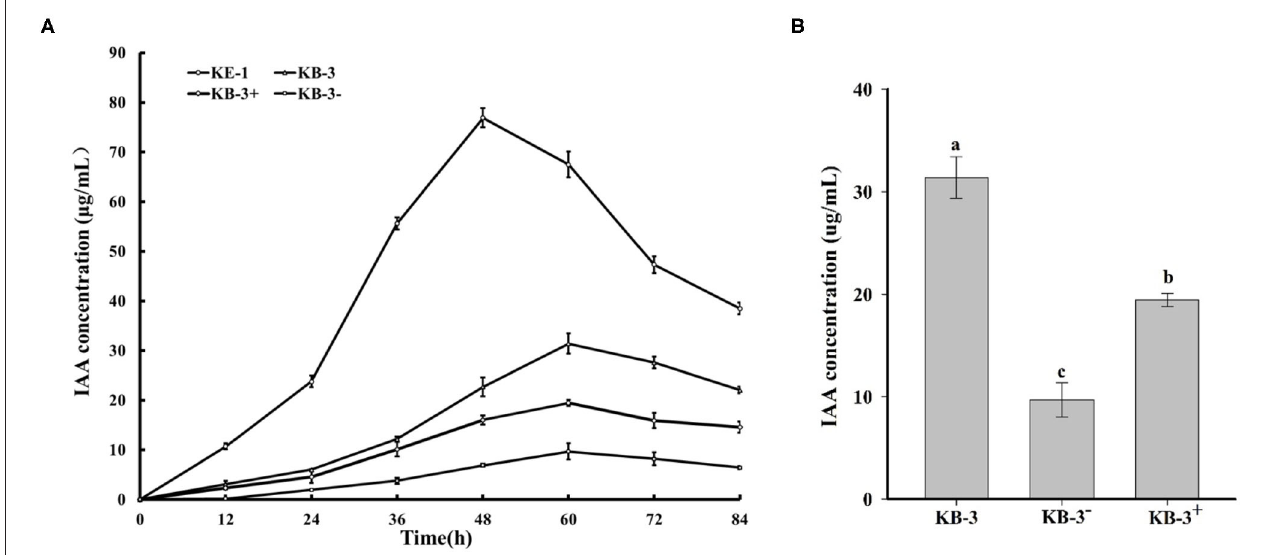
FIGURE 5 | (A) IAA production in the Luria-Bertani (LB) containing 10 mg/ml L-tryptophan cultural broth of wild strain KB-3 of Fusarium oxysporum (KB-3), cured strain KB-3 (KB-3 − ), restored strain KB-3 (KB-3 + ) and its endohyphal bacterium Klebsiella aerogenes KE-1 (KE-1) during 84h post-inoculation. (B) IAA production in the Luria-Bertani (LB) containing 10 mg/ml L-tryptophan cultural broth of wild strain KB-3 of Fusarium oxysporum (KB-3), cured strain KB-3 (KB-3 − ), restored strain KB-3 (KB-3 + ) at 60h after inoculation. The points in (A) and columns in (B) represented the means of two separate experiments, each with three replicates. The interval bars represented the standard deviation of the means. Different letters marked on the top of columns were significantly different according to Duncan’s multiple range test at p <